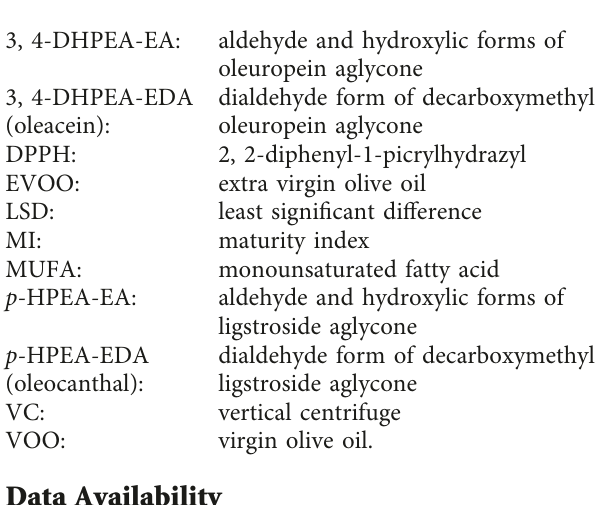
Figure S1. Comparison of the volatile (A) and phenolic (B) compound content in oil before and after centrifugation. Data at the decanter exit and centrifuge exit. The error bars show the standard deviation. Figure S2. Comparison of the volatile (A) and phenolic (B) compound content in un- filtered and filtered oil. Data at the unfiltered and filtered oils. The error bars show the standard deviation. ( Supple- mentary Materials